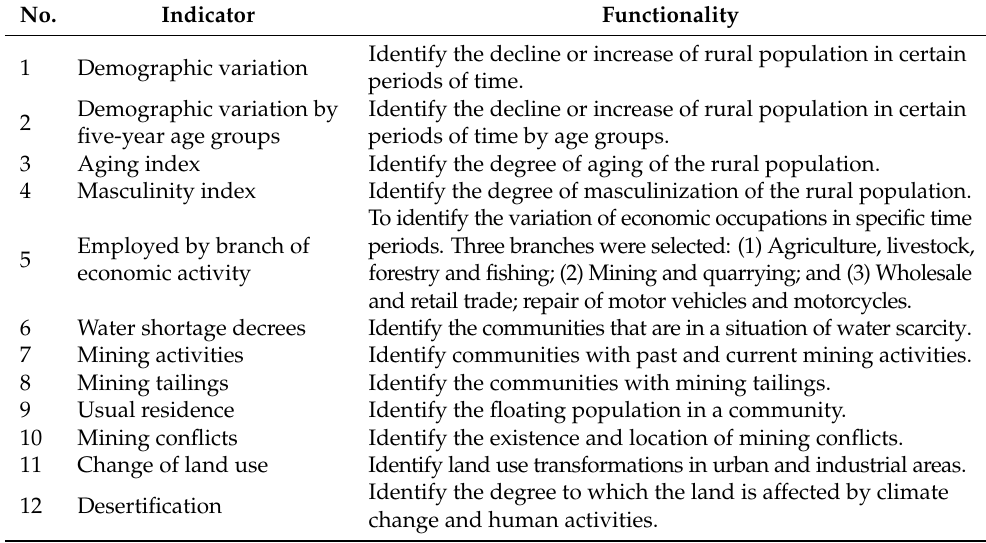
Table 1. Statistical analysis